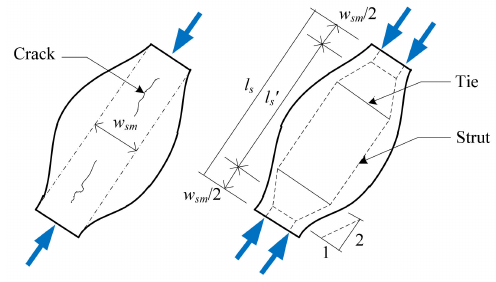
Figure 3. Splitting cracks of a bottle-shaped